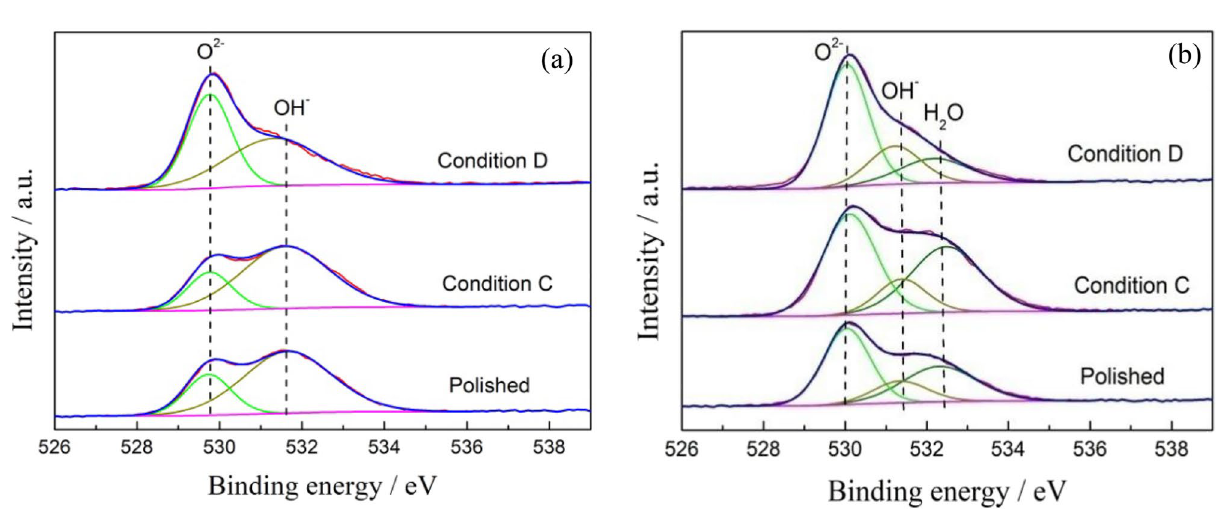
Figure 11. Deconvoluted Ti 2p XPS spectra for ( a ) Ti-6Al-4V and ( b ) Ti-6Al-4V-0.11Ru under different conditions.